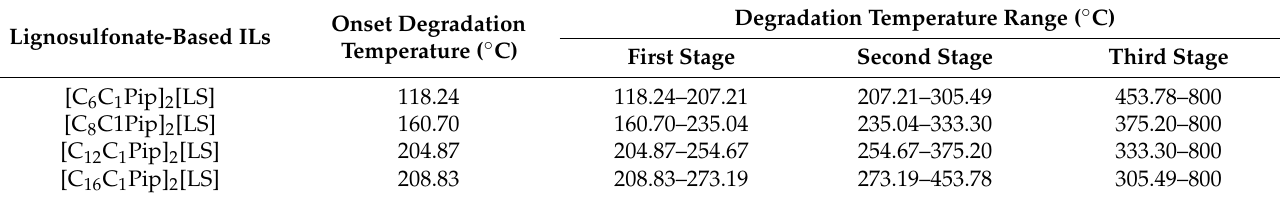
Table 4. Degradation temperature of lignosulfonate-based